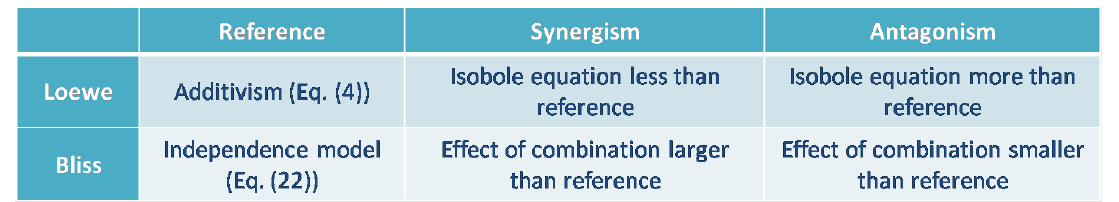
Figure 5. Comparison between Loewe and Bliss models’ definition of